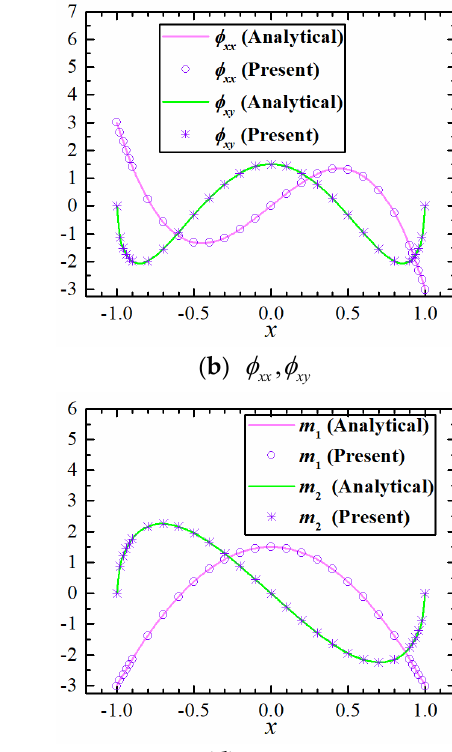
Figure 4. Coefficients of wave-making resistance ( a ) and lift force ( b ) at different Fr .